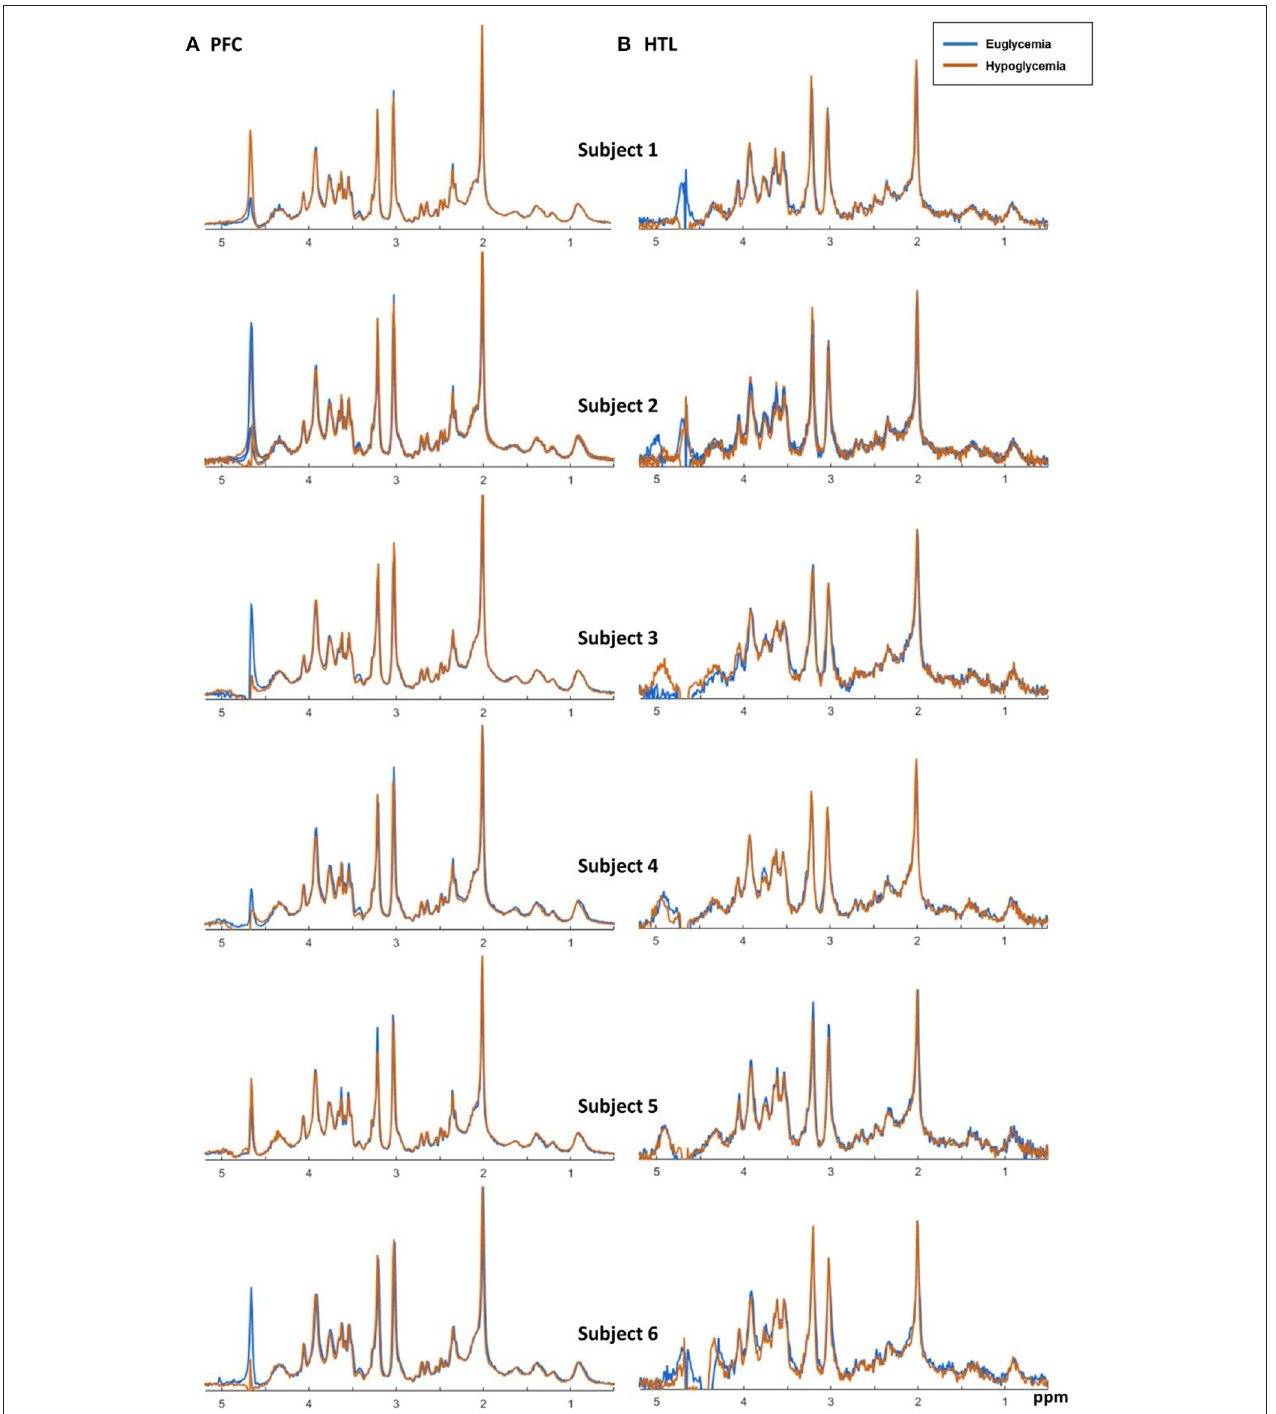
FIGURE 6 | Semi-LASER MR spectra (7T, TR/TE = 5,000/26ms, 64 transients for frontal cortex (PFC) (A) and 256 transients for hypothalamus (HTL) (B) ) acquired from six subjects during glucose clamps.